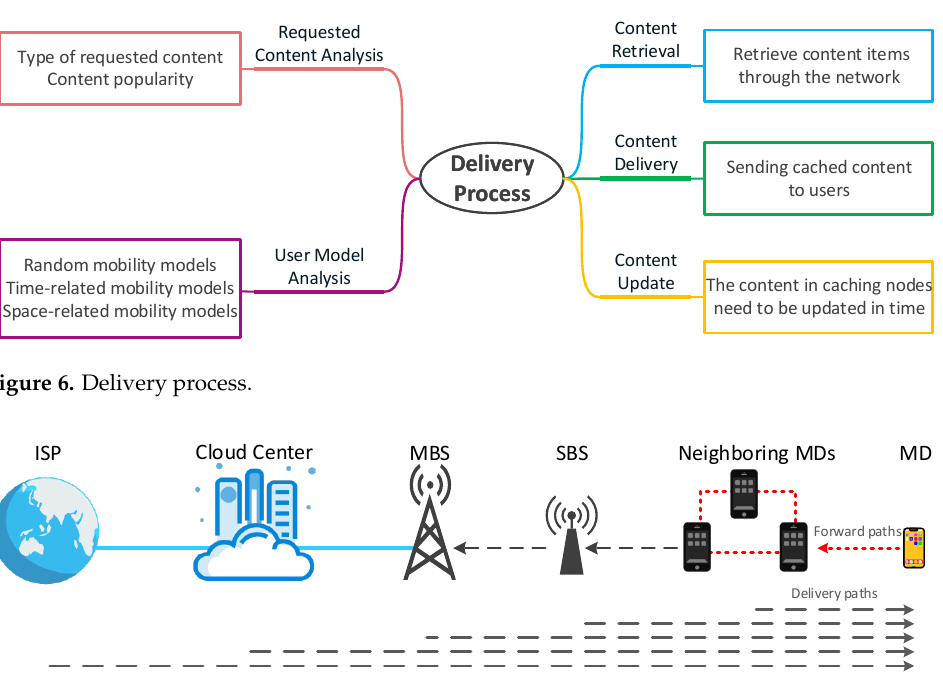
Figure 7. Content retrieval